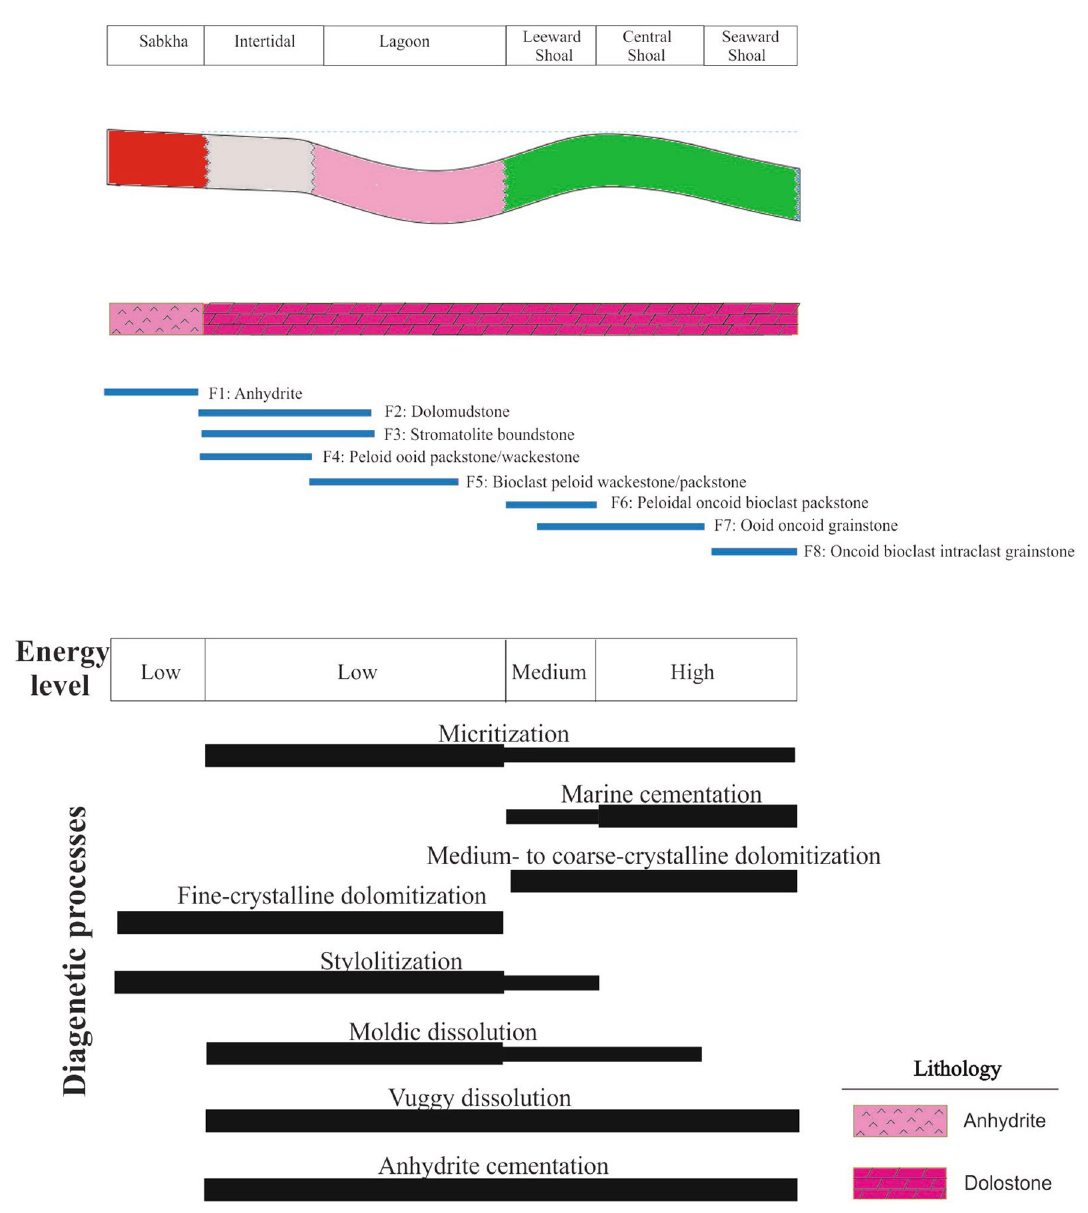
Fig. 3 Depositional model of the Arab Formation reveals the lateral distribution of facies accompanied by diagenetic